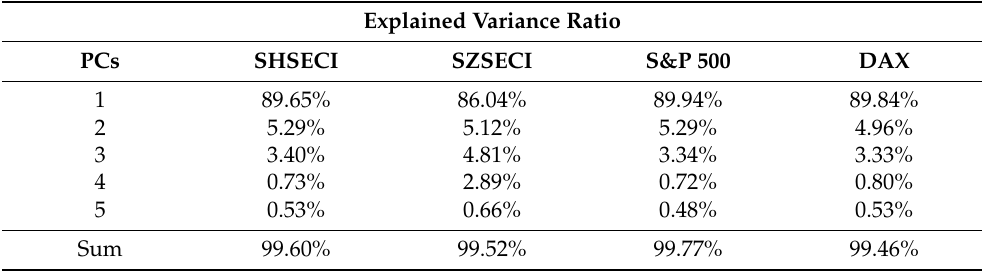
Table 2. Explained variance ratio of four stock